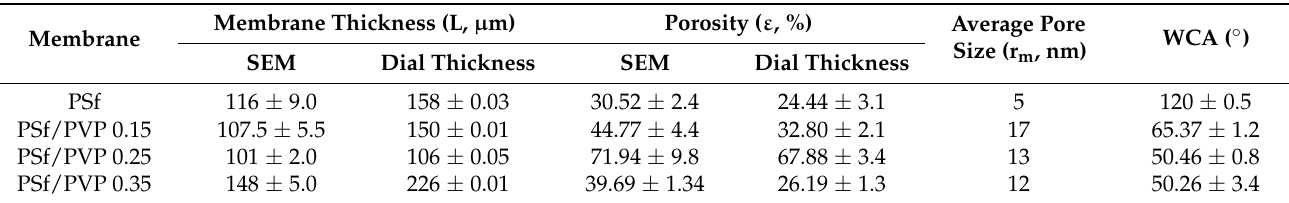
Table 3. Comparison of the results of measurements of membrane thickness, porosity, average pore size, and water contact angle